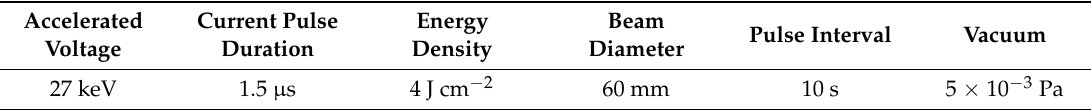
Table 1. Parameters of the high-current pulsed electron beam (HCPEB)